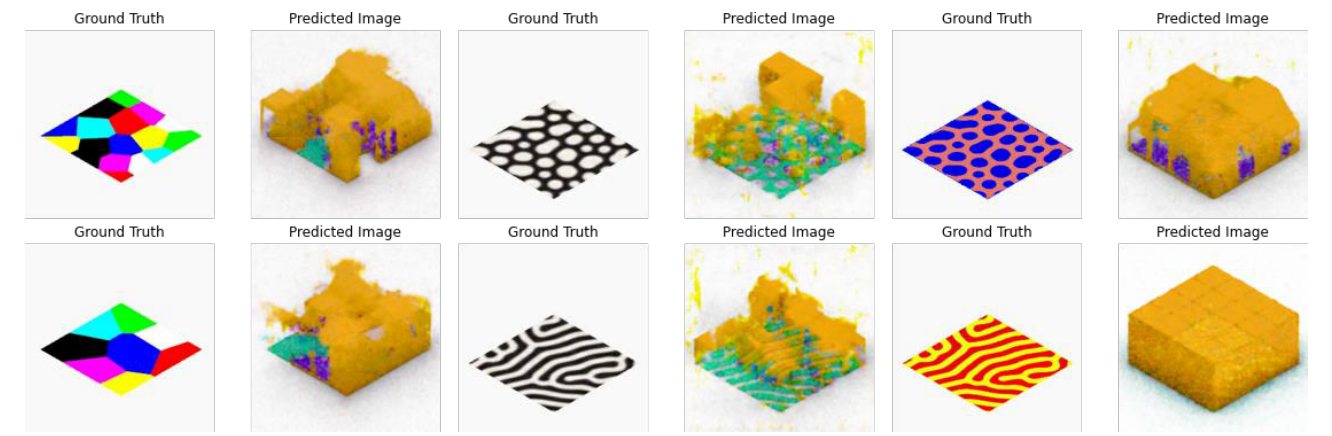
Figure 11. Captures from test D03.